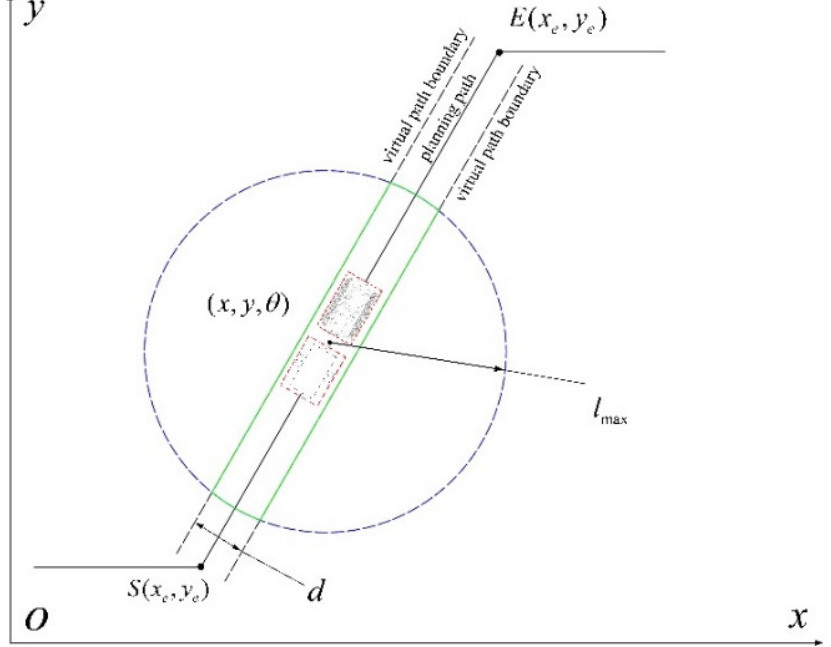
Figure 4. Schematic illustration of the virtual radar map generation.